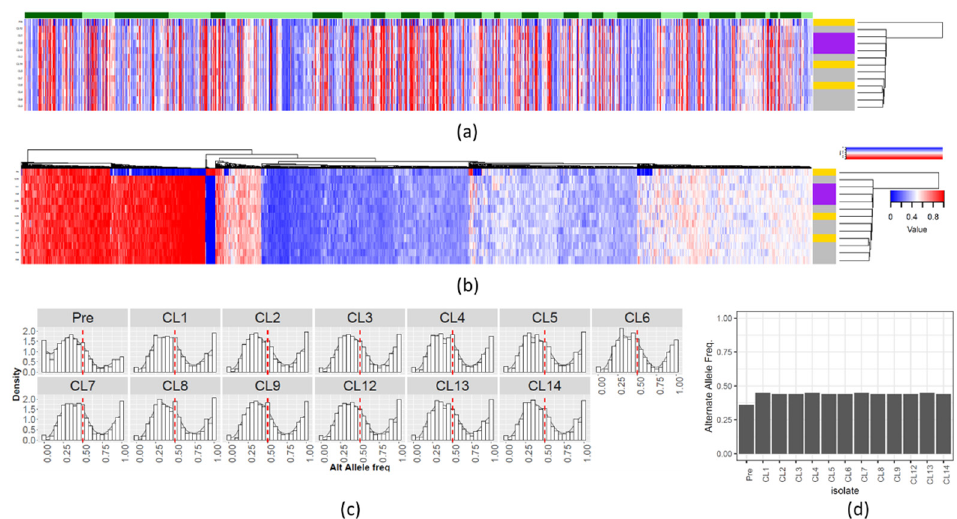
Figure 2. SNVs alternate allele frequency variability. Alternate allele frequency of each SNV position in the L donovani clones and preselection population. ( a ) SNVs ordered by chromosome position. The columns and lines correspond respectively to SNV positions and the various L donovani clones. The allele frequency of the alternate allele is represented in a scale from blue (low) to red (high). The dendrogram on the right represents the UPGMA clustering of the Manhattan distance of the alternate allele frequencies. The color strip beside the dendrogram represents the PMM resistance phenotype, where RI < 2, 2 > RI > 5 and RI > 5 are represented respectively, in yellow, grey and purple. The order of the isolates, from top to bottom, is: “preselection”, “CL 12”,“CL 1”,“CL 8”,“CL 13”,“CL 2”,“CL 14”,“CL 5”,“CL 7”,“CL 6”,“CL 4”,“CL 9” and “CL 13”. The alternating light/dark green color strip on the top represents the chromosomes 1–36. ( b ) The SNVs columns were reordered by UPGMA clustering of the Manhattan distance, instead of being ordered by chromosome position. ( c ) Genome-wide density plot of the alternate allele frequency distribution of SNVs in the 12 clones and the preselection population. The X and Y axis represent, respectively, the alternate allele frequency (from 0 to 1) and the allele frequency rate. The red dashed line represents an alternate allele frequency of 0.5, the expected value for disomic chromosomes. The observed distribution is suggestive of triploidy. ( d ) Median genome-wide allele frequency for each clone and the preselection population (Pre).